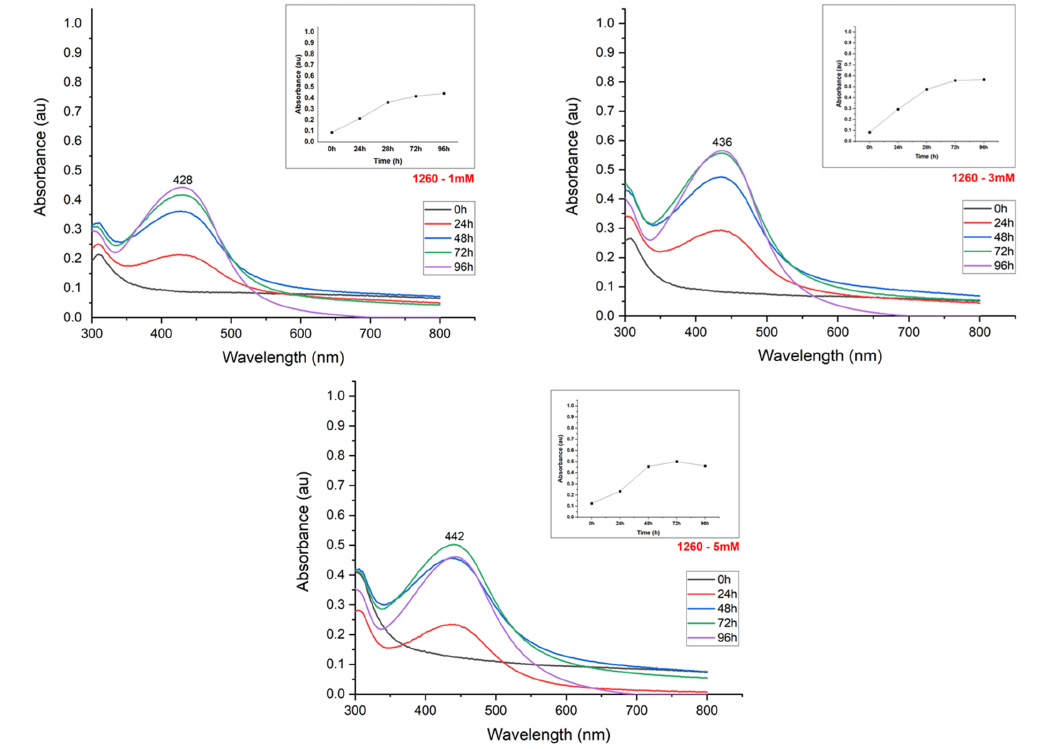
Figure 3. UV-Visible absorption spectrum of the evaluation of the effect of silver nitrate concentration on the synthesis of silver nanoparticles using an extract of the fungus B. bassiana (isolate 1260). The maximum absorbance evaluation (UV-Visible absorption spectrum) allowed us to estimate the nanoparticle synthesis rate according to the incubation time (Figures 3–6). The nanoparticle formation stabilized at 96 h in the presence of AgNO 3 3 mM and 1260, SE109, and SE301 extracts, allowing sufficient time for the silver ions depletion. The most suitable incubation time was observed at 72 h in the presence of AgNO 3 5 mM and 1260 aqueous extract for the nanoparticle synthesis. The nanoparticle synthesis rate depends mainly on the characteristics of the metabolite responsible for the reduction of silver. A study reported the absorbance stabilization peak at 8 min of incubation using AgNO 3 1 mM in the presence of Ocimum sanctum extract in the nanoparticle synthesis [17]. Another study showed an increase in nanoparticle formation at 48 h using the extract of cyanobac- teria Oscillatoria limnetica [18]. Differences in the incubation time are expected for the bio- logical synthesis of silver nanoparticles once extracts from different organisms present quantitative and qualitative differences in their compounds.